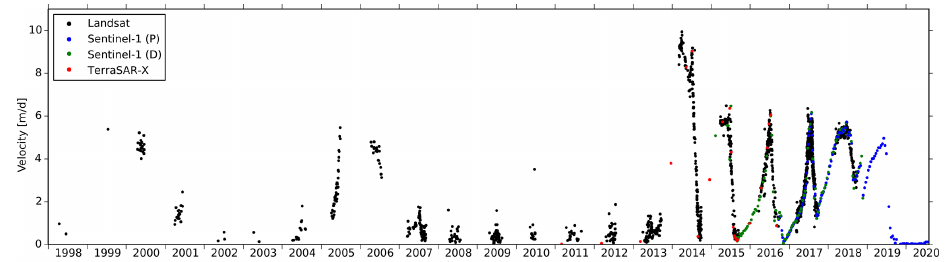
Figure 2. Flow velocity for the time period from January 1998 to July 2020 derived from Landsat, Sentinel-1, and TerraSAR-X at a point close to the terminus of Harald Moltke Bræ. For Sentinel-1 we use two different velocity data sets: one processed at Denmark’s National Space Institute (DTU Space), referred to as Sentinel-1 (D), and another one provided by the Programme for Monitoring of the Greenland Ice Sheet (PROMICE), referred to as Sentinel-1 (P).